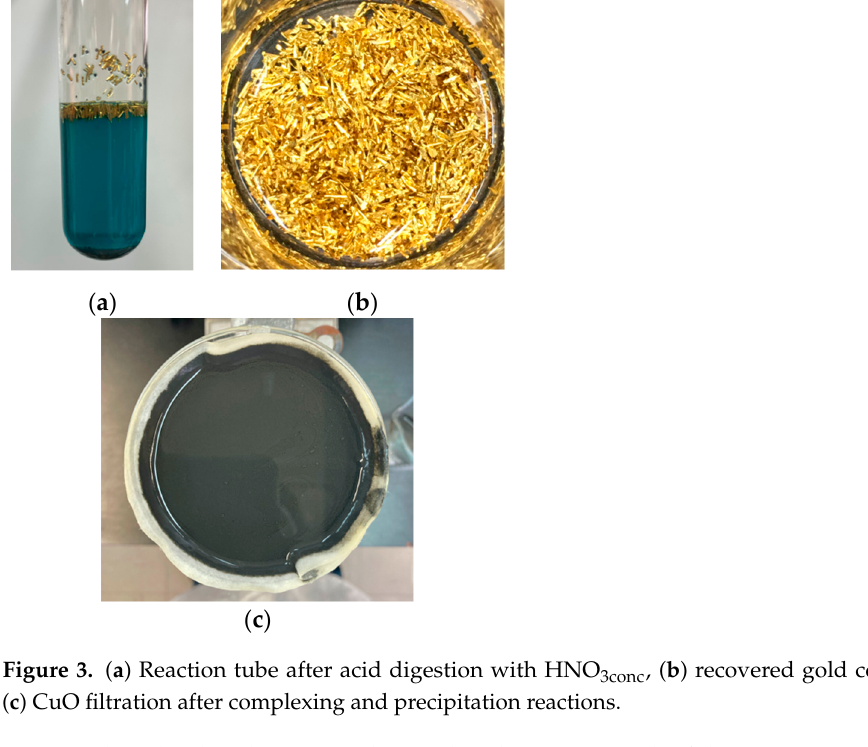
Element Au Ni Fe Cu Mass contained (g) 0.0199 0.1050